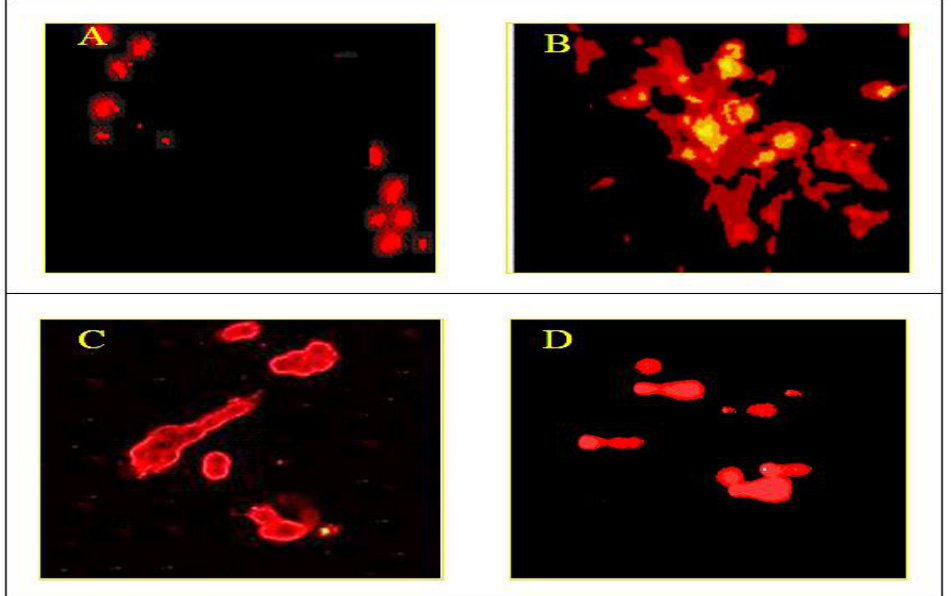
Figure 5. Effect of plant compound and clozapine on the production of ROS in PC 12 cell lines during ketamine induction in vitro. ( A ) PC 12 cell line (control). ( B ) PC 12 cell line treated with ketamine for 12 h. ( C ) PC 12 cell line treated with clozapine for 2 h after ketamine treatment. (D ) PC 12 cell line treated with compound for 2 h before ketamine treatment. Scale: 100 μ m.